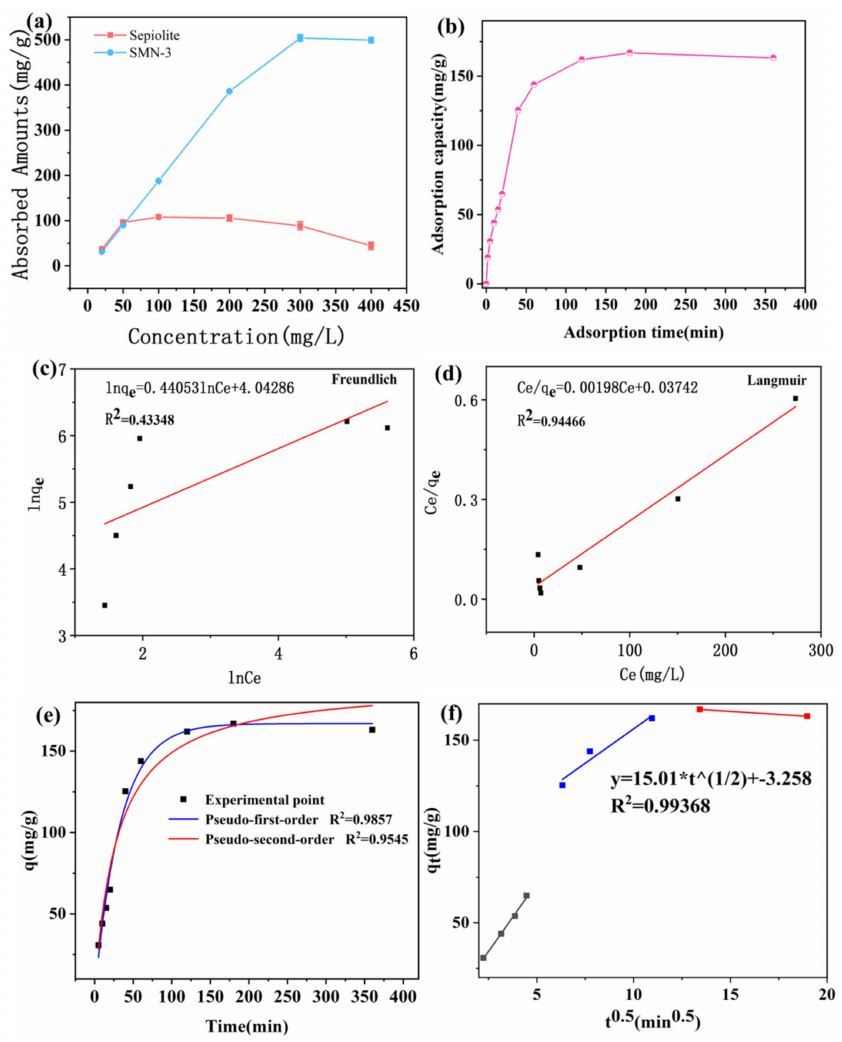
Figure 4. ( a ) Adsorption capacity of sepiolite and SMN-3 (dosage = 25.00 mg, t = 12 h, pH = 5, T = 25 ◦ C); ( b ) the effect of contact time on adsorption (dosage = 25.00 mg, Pb(II) initial concentration = 100 mg · L − 1 , pH = 5, T = 25 ◦ C); ( c , d ) a linear fit of Freundlich and Langmuir model; ( e , f ) nonlinear adsorption kinetics model and intra-particle diffusion